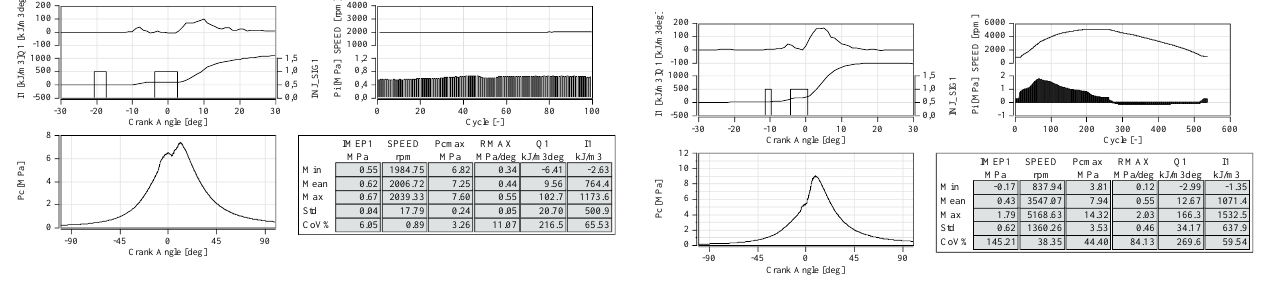
Fig. 10. A vehicle driving with engine rotational speed of about 2000 rpm Fig. 14. The vehicle acceleration in the second gear with the throttle open in the fourth gear, with diesel fuel supply; The courses of developing heat at maximum, with diesel supply; The courses of developing heat (Q1) and (Q1) and amount of developed heat (I1), mean indicator pressure (IMEP1) amount of developed heat (I1), mean indexed pressure (IMEP1) are pre- are presented sented are